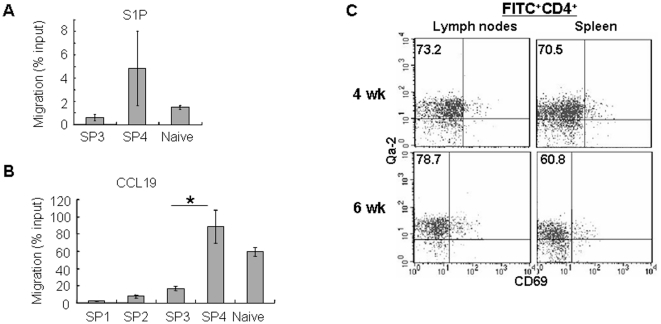
Cells with the SP4 phenotype are the main population in RTEs.(A-B) Transwell migration of SP thymocytes and naïve CD4+ T cells to S1P (A) and CCL19 (B). Three experiments were performed and the mean and standard deviation were shown. Asterisks indicate significant (P<0.05) difference between SP3 and SP4 subsets. (C) Phenotype of RTEs. Twenty-four hours after intrathymic injection of FITC, the cells from the lymph nodes and spleen were harvested and stained with CD4, Qa-2 and CD69. The surface expression of Qa-2 and CD69 in FITC+CD4+ T cells are shown. The numbers represent the percentage of Qa-2+CD69- cells in FITC+CD4+ T cells. The experiment was repeated for two more times and similar results were obtained.